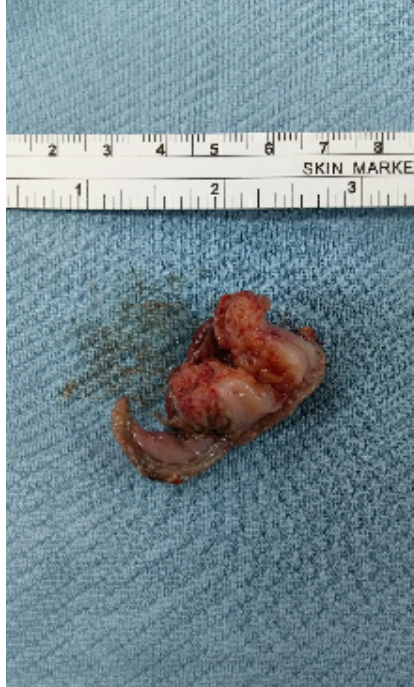
Figure 4. Gastric subepithelial tumor retrieved from specimen bag after laparoscopic endoscopic cooperative surgery.